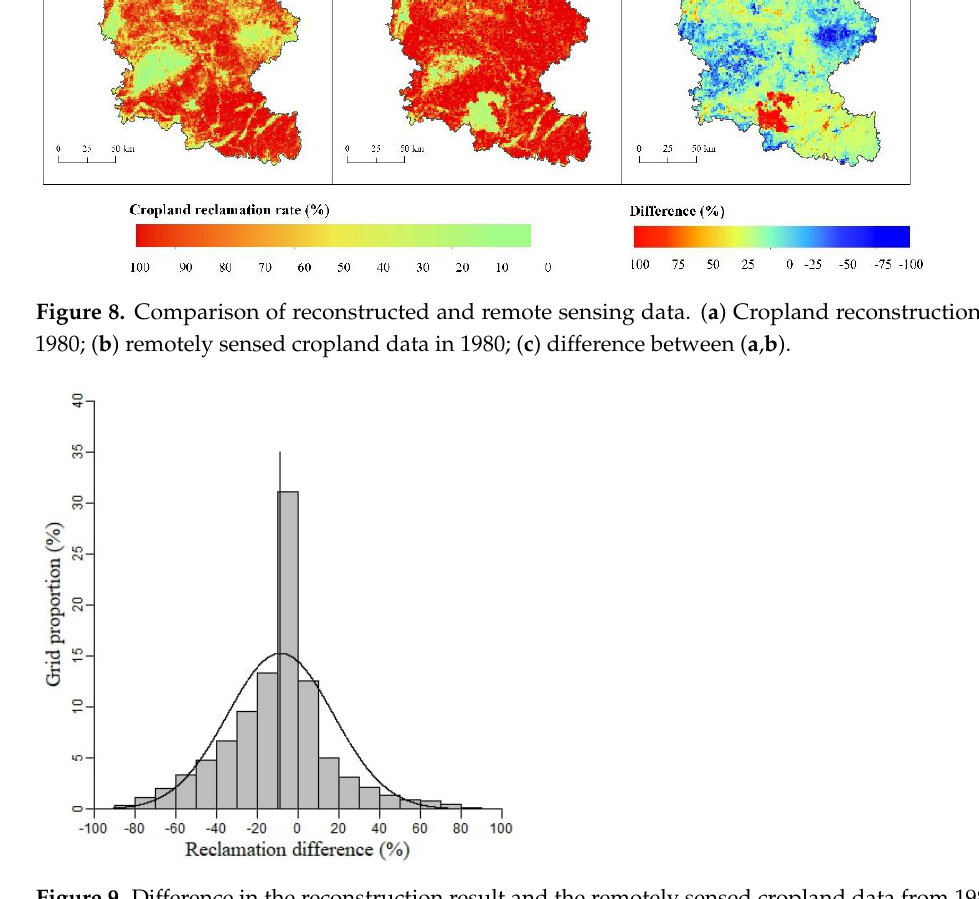
Figure 9. Difference in the reconstruction result and the remotely sensed cropland data from 1980.